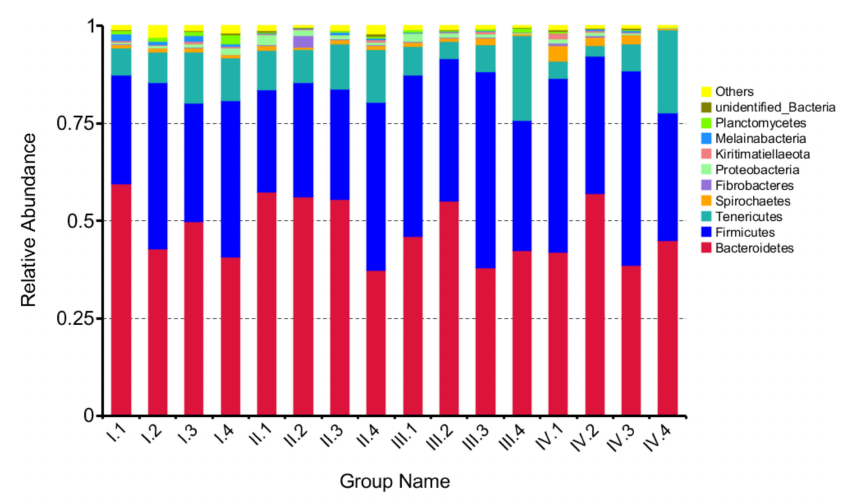
Figure 2. The column chart of the main dominant phyla. A color-coded bar plot, showing the bacterial phylum distribution across the di ff erent groups in di ff erent periods that were sampled. Periods I (1–18 d), II (19–36 d), III (37–54 d), and IV (55–72 d). Group 1, 2, 3, and 4 represents four groups of sheep treated with four dietary NFC / NDF ratio of 0.54, 0.96, 1.37, and 1.90, respectively.